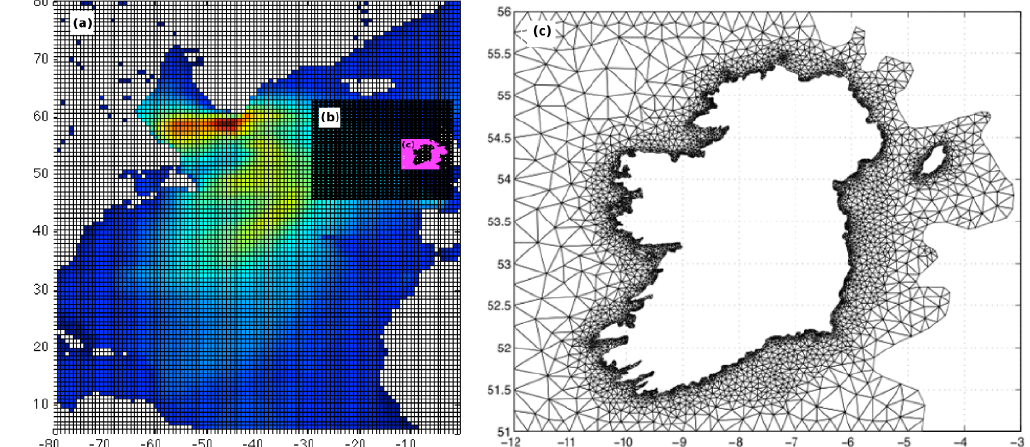
Figure 1. (a–c) The three wave model grids as described in Gallagher et al. (2016a). (a) The large North Atlantic grid has a 0 . 75 ◦ × 0 . 75 ◦ resolution. (b) The grid for the Northeast Atlantic has a 0 . 25 ◦ × 0 . 25 ◦ resolution. Right panel (c) The wave model unstructured grid around Ireland has a resolution ranging from 15km offshore to 1km in the nearshore characterised by 4473 nodes.